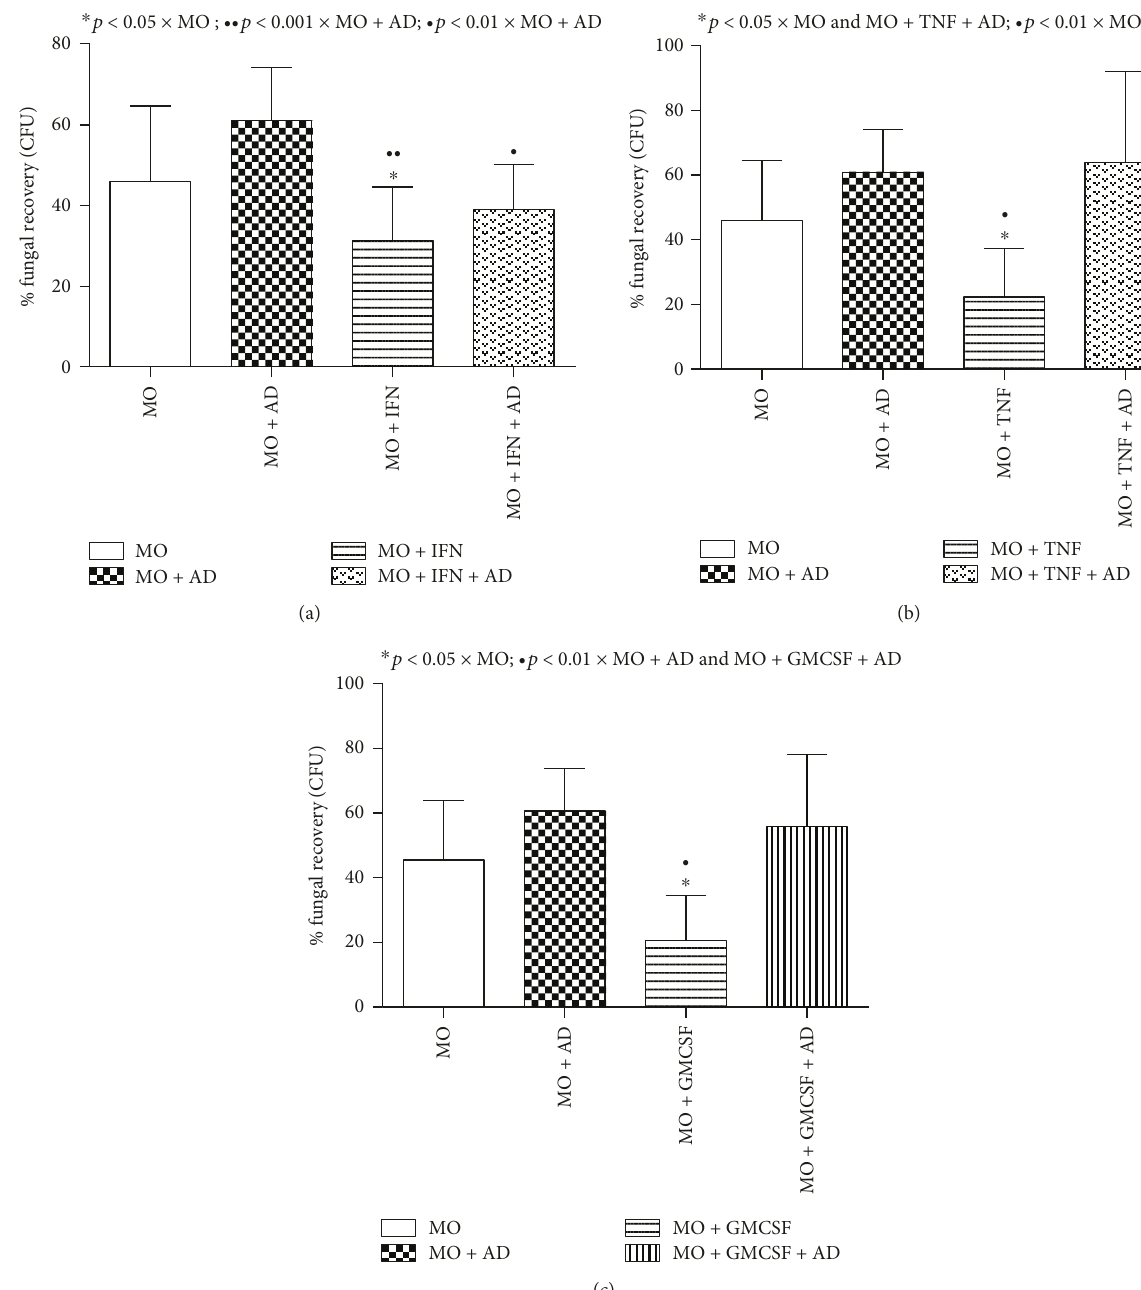
Figure 3: Percentage of fungal recovery by colony-forming unit (CFU) analysis of monocyte (MO) cultures treated or not with IFN- γ (a), TNF- α (b), and GM-CSF (c) for 18 hours in the presence or absence of the anti-Dectin-1 monoclonal antibody (AD) and challenged with Pb265 for 4 hours. Data are expressed as the mean of 8 healthy volunteer donors tested. Statistical signi fi cance between groups is